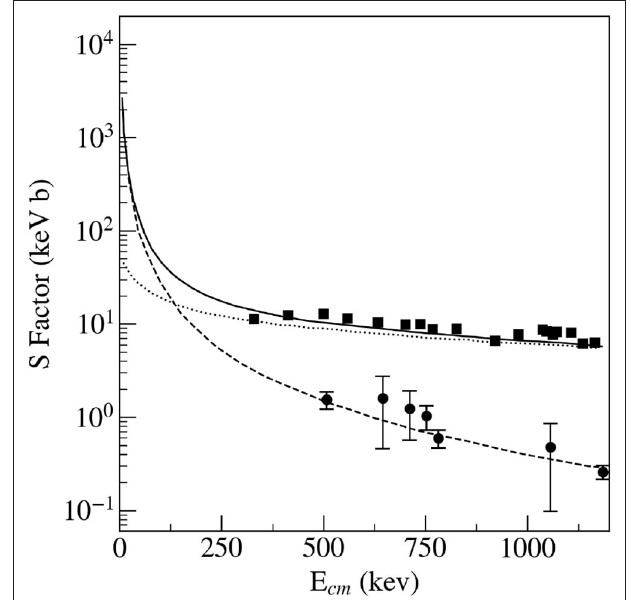
FIGURE 9 | The astrophysical S-factor for the direct 20 Ne(p, γ ) 21 Na capture. The solid squares and dotted curve are experimental data points from Rolfs et al. (1975) and results of Mukhamedzhanov et al. (2006) for direct capture to the subthreshold state, respectively. Similarly, for the capture to the ground state the open squares and dashed curve correspond to the experimental data points and to results for the direct capture. The determined total astrophysical S-factor is given by the solid